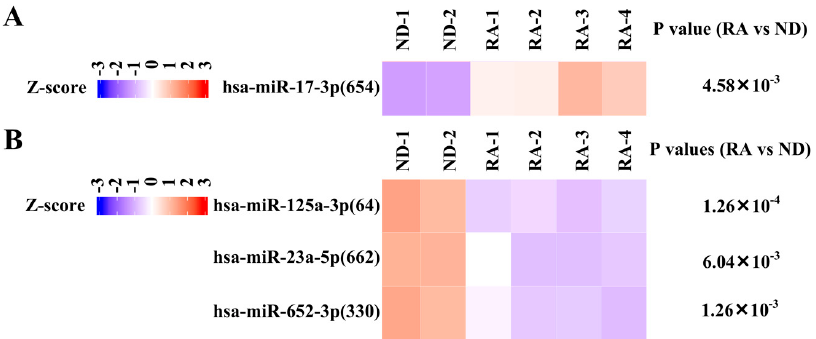
Figure 5. Expression of hsa-miR-17-3p, hsa-miR-125a-3p, hsa-miR-23a-5p, and hsa-miR-652-3p in Gene Expression Omnibus (GEO) dataset. ( A ) Heatmap showing the scaled expression of upregulated miRNA (hsa-miR-17-3p) in rheumatoid arthritis (RA) synovial fibroblasts compared with normal donor (ND) synovial fibroblasts as well as P value in GSE37276 with probe identification shown in parentheses. ( B ) Heatmap showing the scaled expression of downregulated miRNA (hsa-miR-125-3p, hsa-miR-23a-5p, hsa-miR-652-3p) as well as P values in GSE37276 with probe identification shown in parentheses. Diagnostics 2019 , 9 , x FOR PEER REVIEW